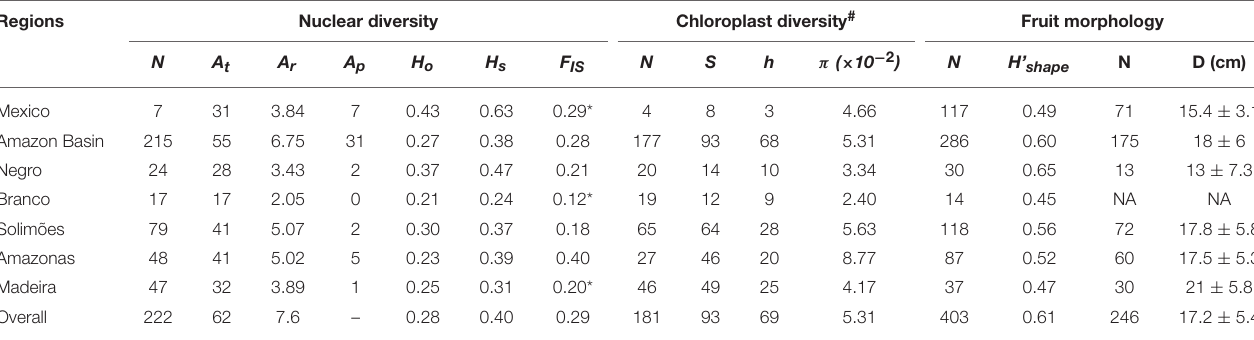
TABLE 2 | Genetic diversity of cultivated Crescentia cujete in Mexico and along major rivers of the Brazilian Amazonia, based on 8 nuclear SSR, 93 chloroplast SNPs and eight fruit shapes. Regions Nuclear